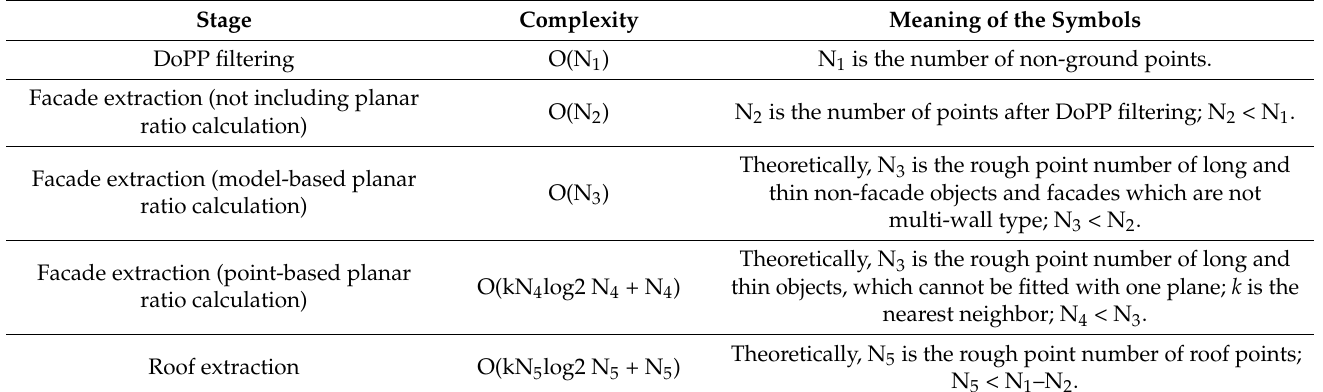
Table 5. Time complexity of different stages in the proposed